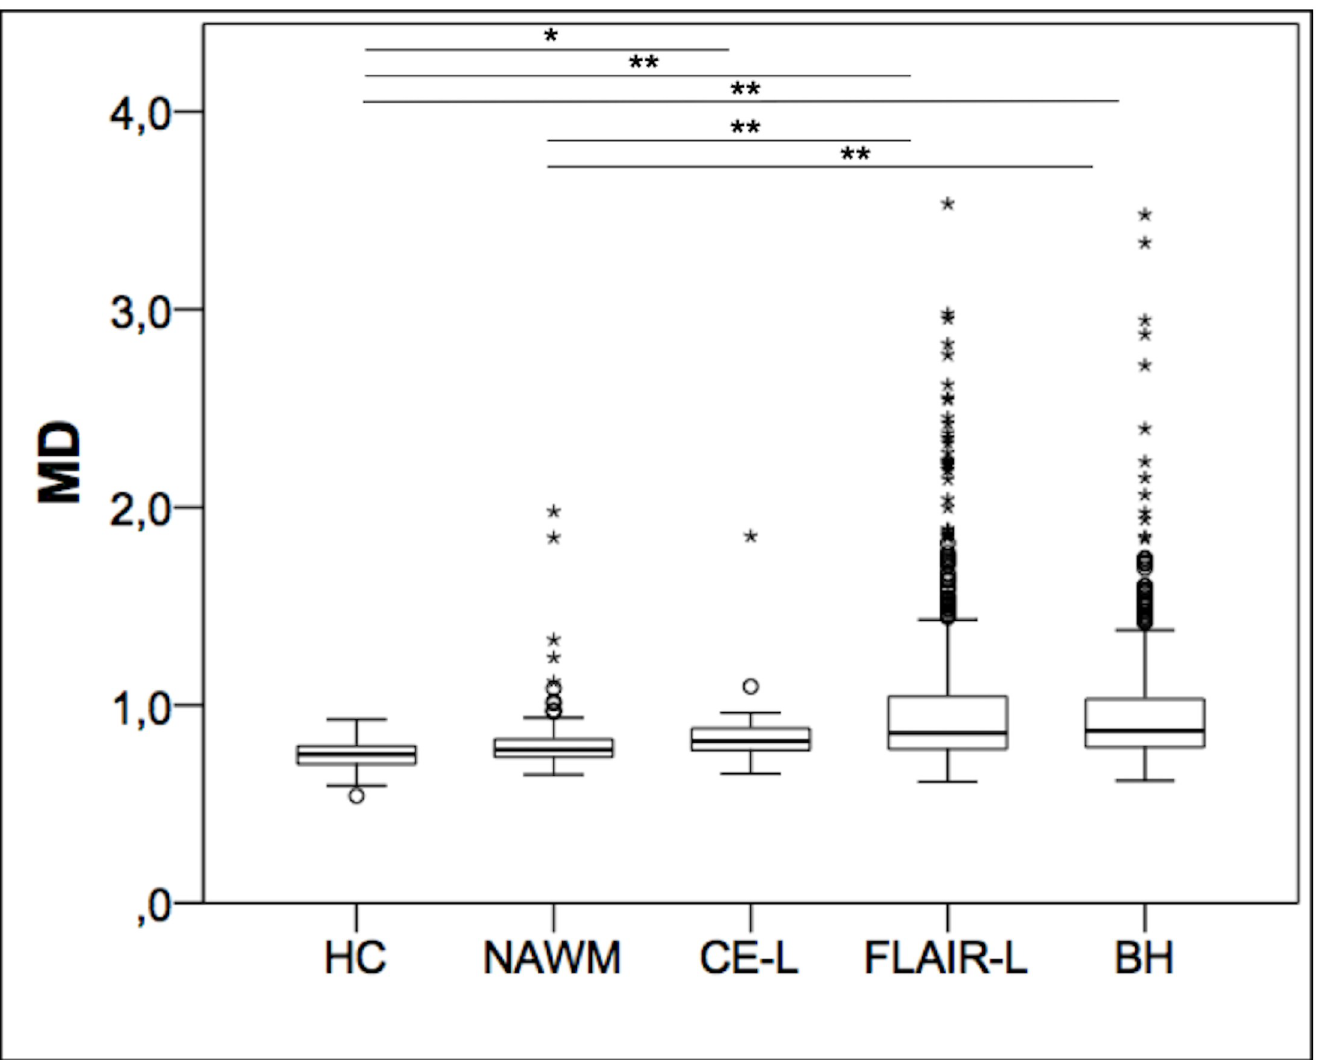
Fig 4. Distribution of mean diffusivity (MD) within the different lesion categories. Boxplots of MD (10 − 3 mm 2 /sec) in the white matter of healthy controls (HC), normal appearing white matter (NAWM) of MS patients, contrast-enhancing lesions (CE-L), FLAIR lesions (FLAIR-L) and black holes (BH). � = p < 0.05, �� = p < 0.001.